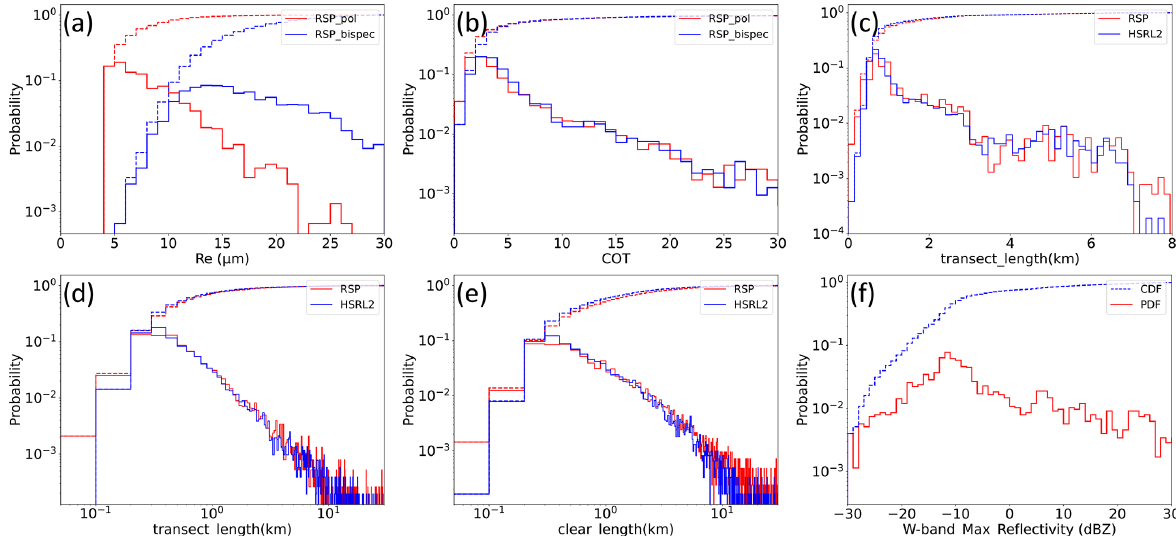
Figure 2. Probability distribution function (PDF, solid line) and cumulative distribution function (CDF, dashed line) for cloud element mean values of (a) the RSP polarimetric and bi-spectral R e , (b) the RSP polarimetric and bi-spectral COT, (c) CTH from RSP and HSRL-2, (d) cloud element transect length from RSP and HSRL-2, (e) clear segment length (between cloud elements) from RSP and HSRL-2, and